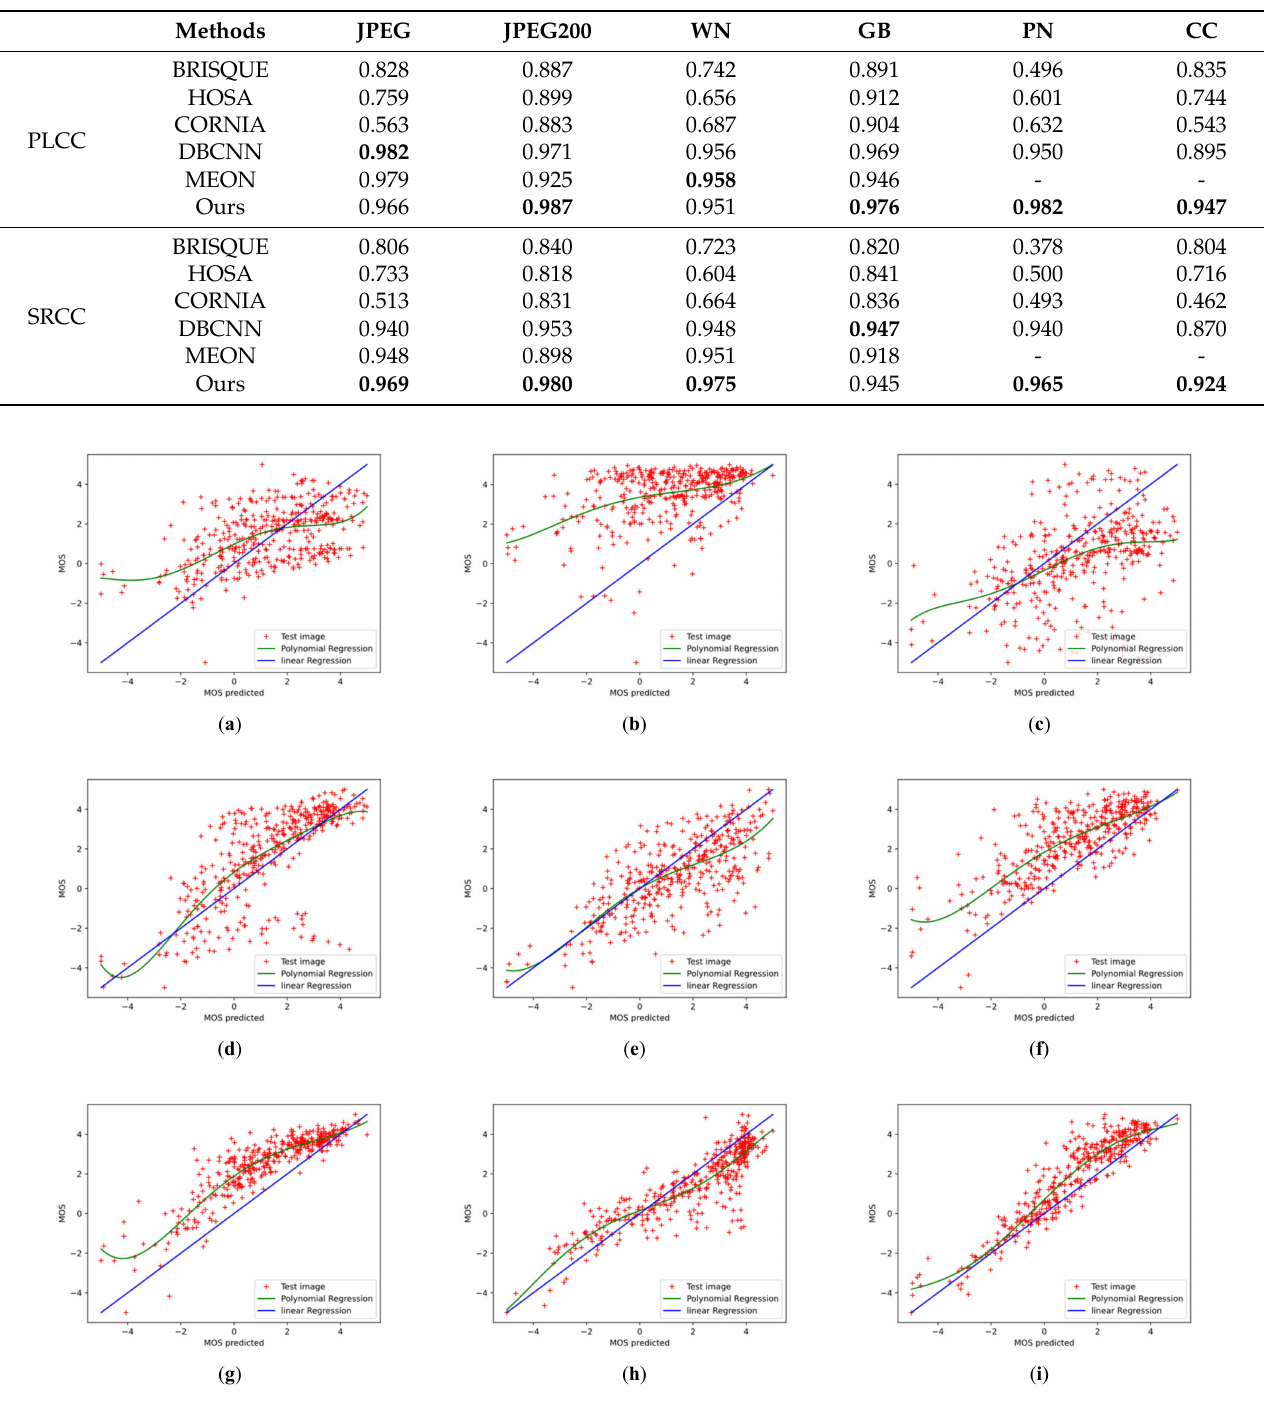
Table 4. Average PLCC and SRCC results of individual distortion types on the CSIQ databases. The top performing method is highlighted in bold face.